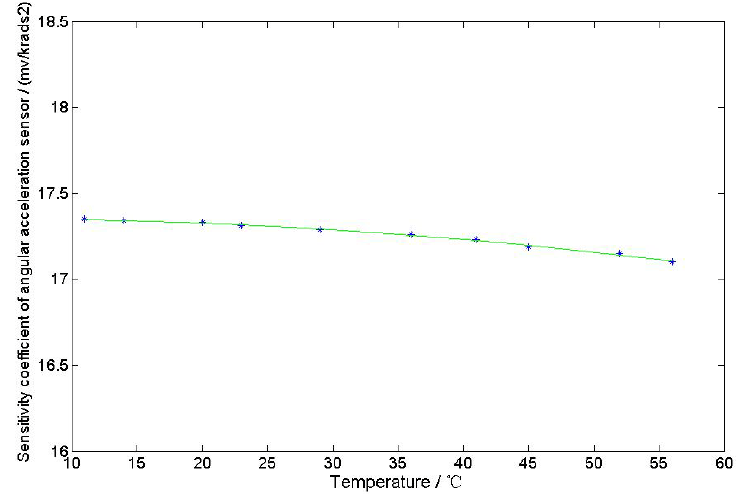
Figure 13. Temperature-sensitivity coefficient characteristics of the